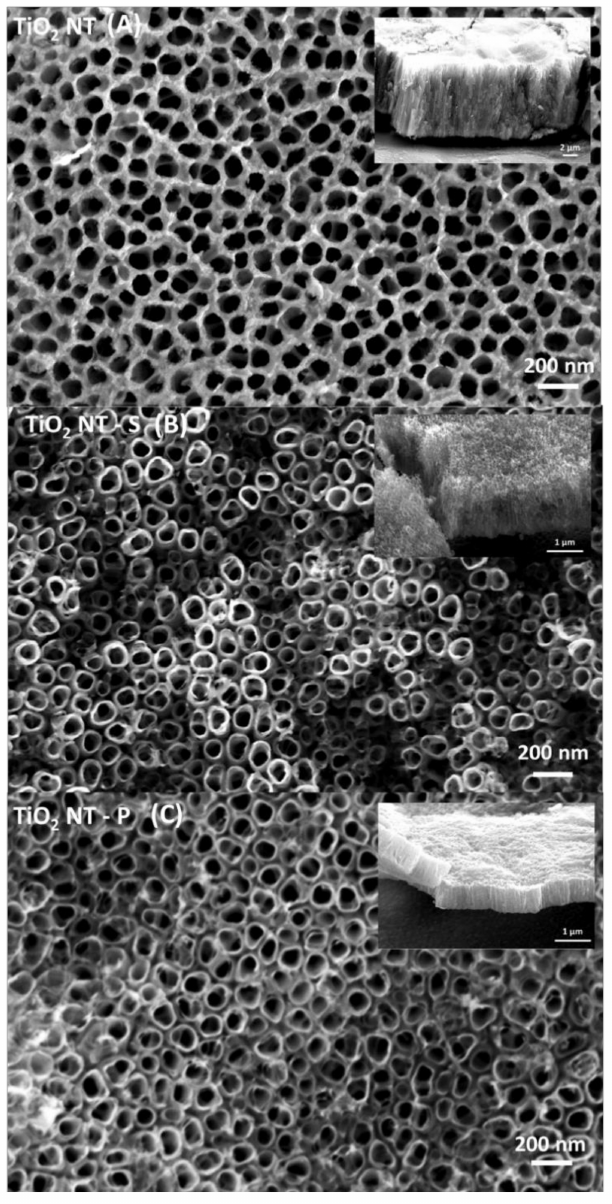
Figure 1. Scanning Electron Microscopy (SEM) image showing the morphology of the different arrays ( A ) TiO 2 NT-O, ( B ) TiO 2 NT-S, ( C ) TiO 2 NT-P. The insets show a side view of a mechanically removed